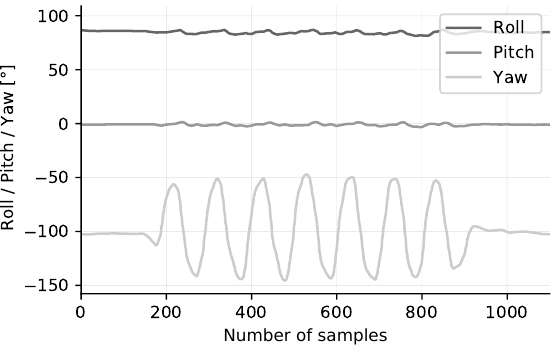
Figure 15. Exercise: Rotation of the back. A periodic movement with a variation of ± 50 ◦ on the yaw axis can be observed. The roll and pitch axis are stable.